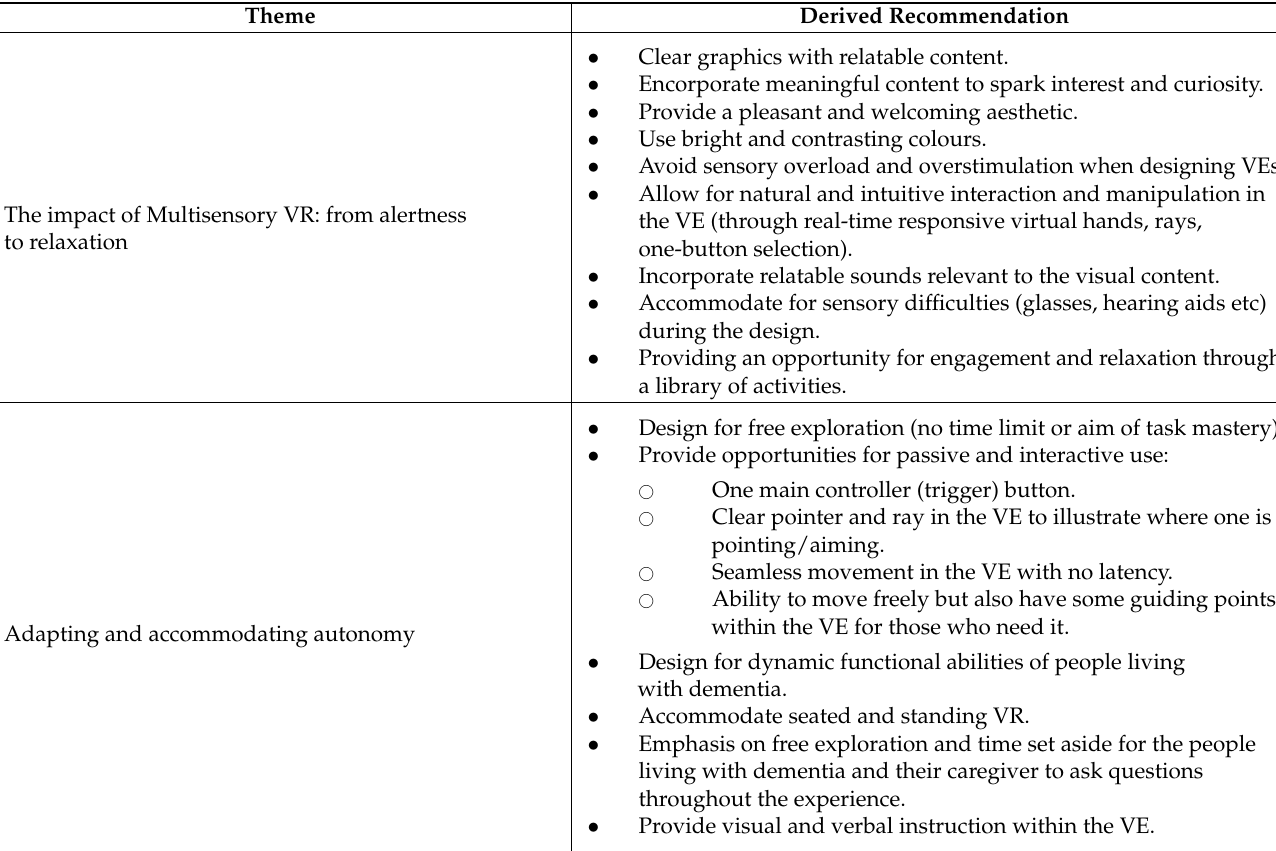
Table 5. Design and implementation recommendations for VR technology